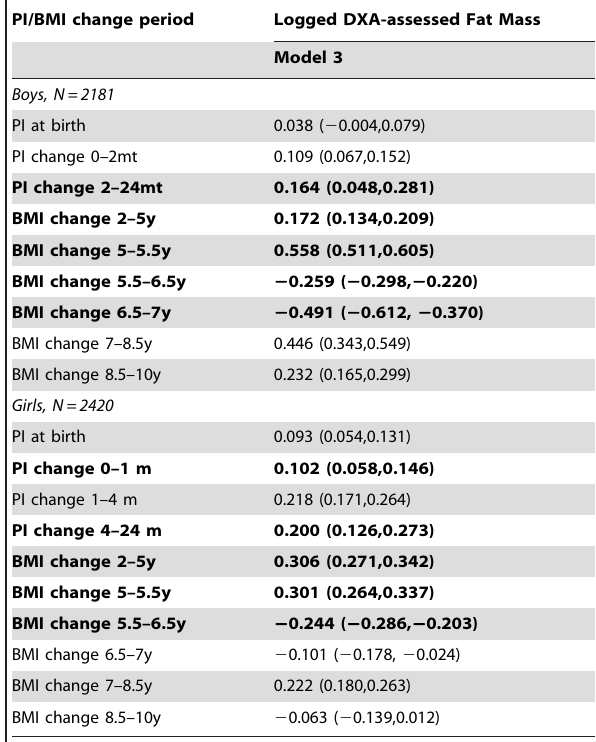
Table 2. PI/BMI trajectories from birth to ten years and their association with Ln of DXA-assessed total body fat mass at age 15 years, with multiple imputation, adjusted for age, previous periods of PI/BMI change and